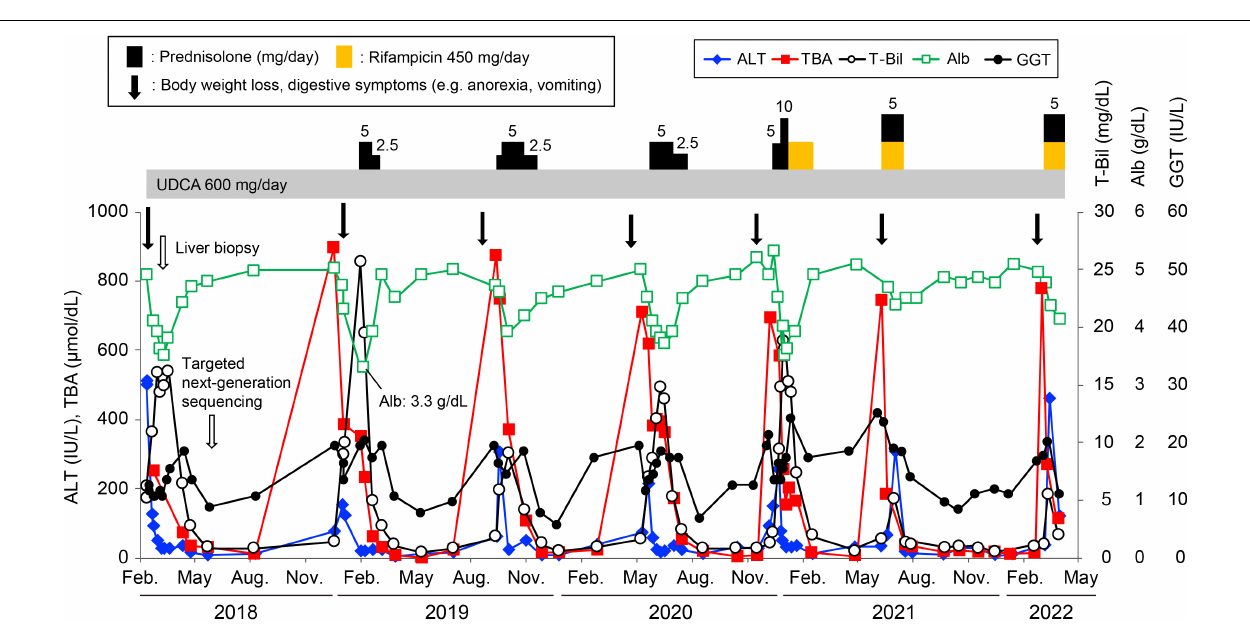
), albumin (Alb, (cid:3) ), and (cid:35)